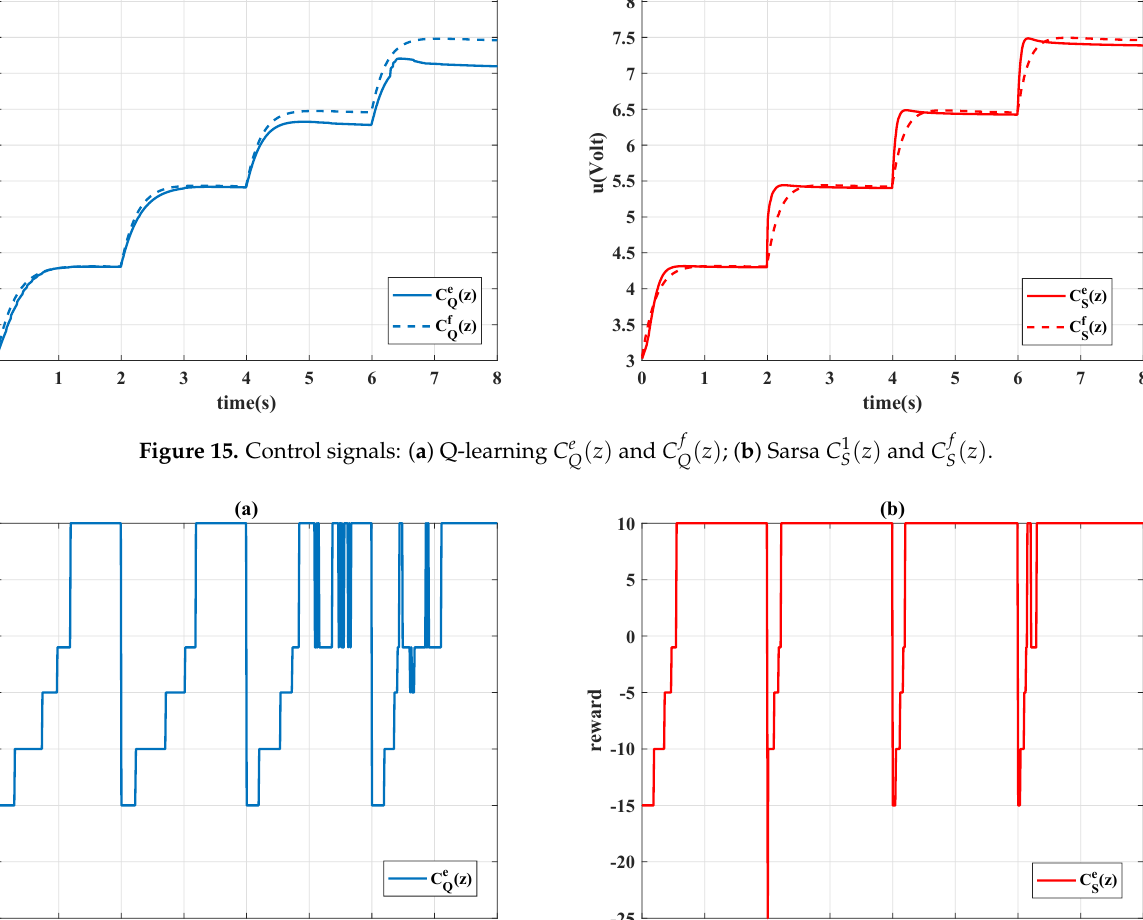
Figure 16. Learning curves of: ( a ) Q-learning C e